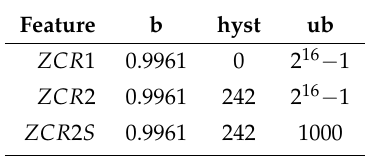
Figure 5. Exemplary sketches of features. Note that different variants of the sketched features were calculated. ( a ) Zero-Crossing (ZC): The crossings of the raw signal through the zero line are detected. ( b ) Mean crossing (MC): The crossings of the raw signal through the smoothed signal (+/ a hysteresis) − are detected. ( c ) Slope Sign Change (SSC): The changes of the slope sign of the raw signal are detected. Table 1. Parameters of ZCR